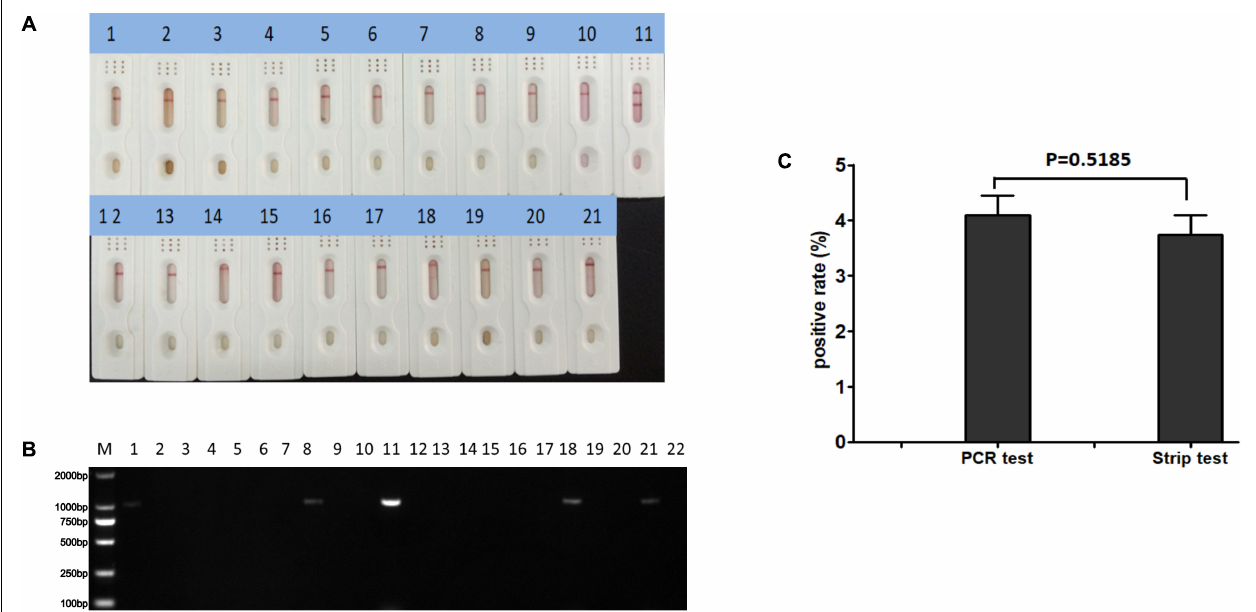
FIGURE 6 | Practical application of the ICS assay. Detection of various clinical samples (1–10, 12–21) using (A) the ICS assay or (B) specific PCR. Positive (sample 11) and negative (sample 22) controls were included in each. (C) Rates of positive sample detection comparing the PCR and ICS test.